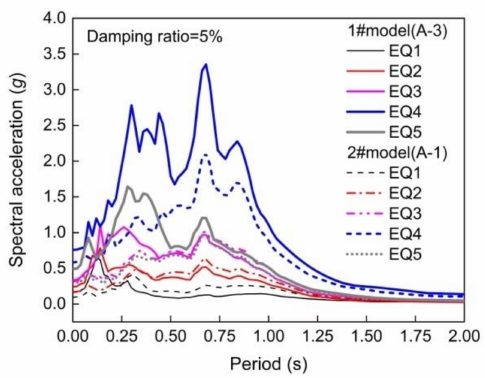
Figure 10. Response spectral accelerations of the slope crest (5% damping